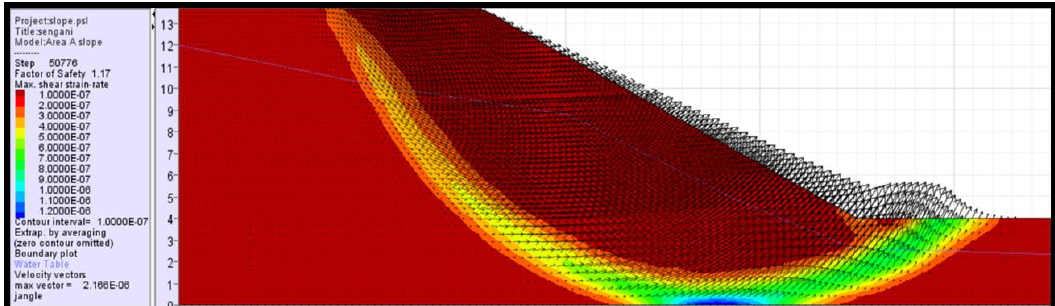
Figure 16. Simulated FoS of the clay soil slope using FLACSlope in rainy conditions with water table with 1500 m 3 of water. Note that maximum shear strain simulated ranges between 1.0 × 10 −8 to 4.007 × 10 − 5 .